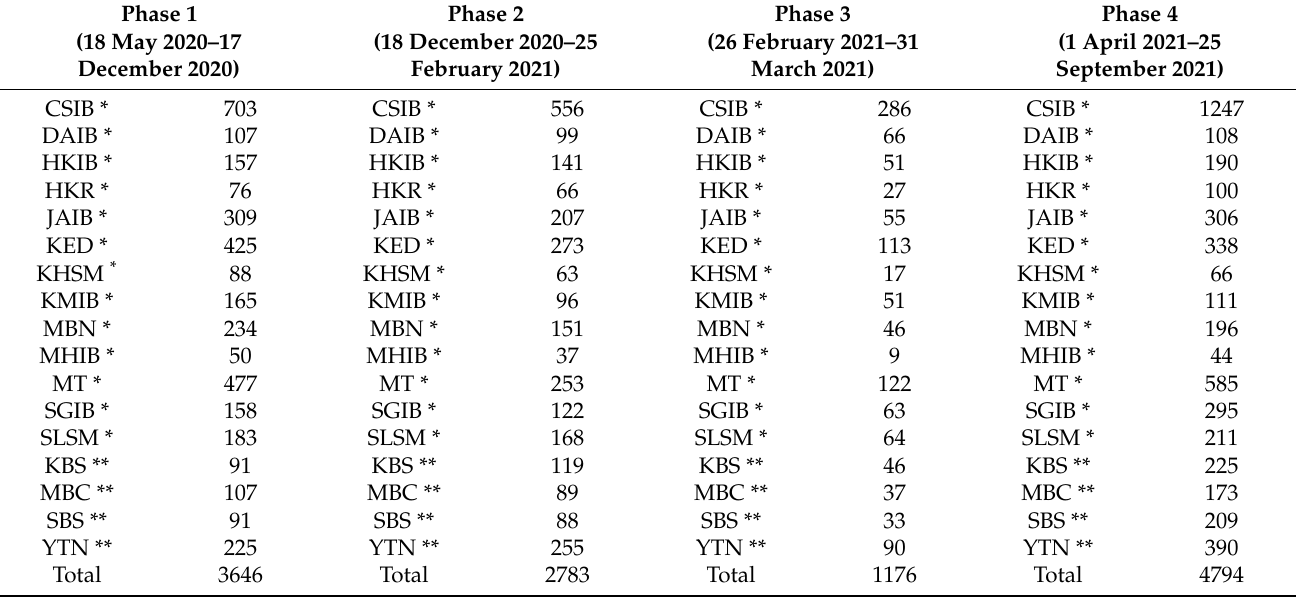
Table 1. The number of articles extracted during each COVID-19